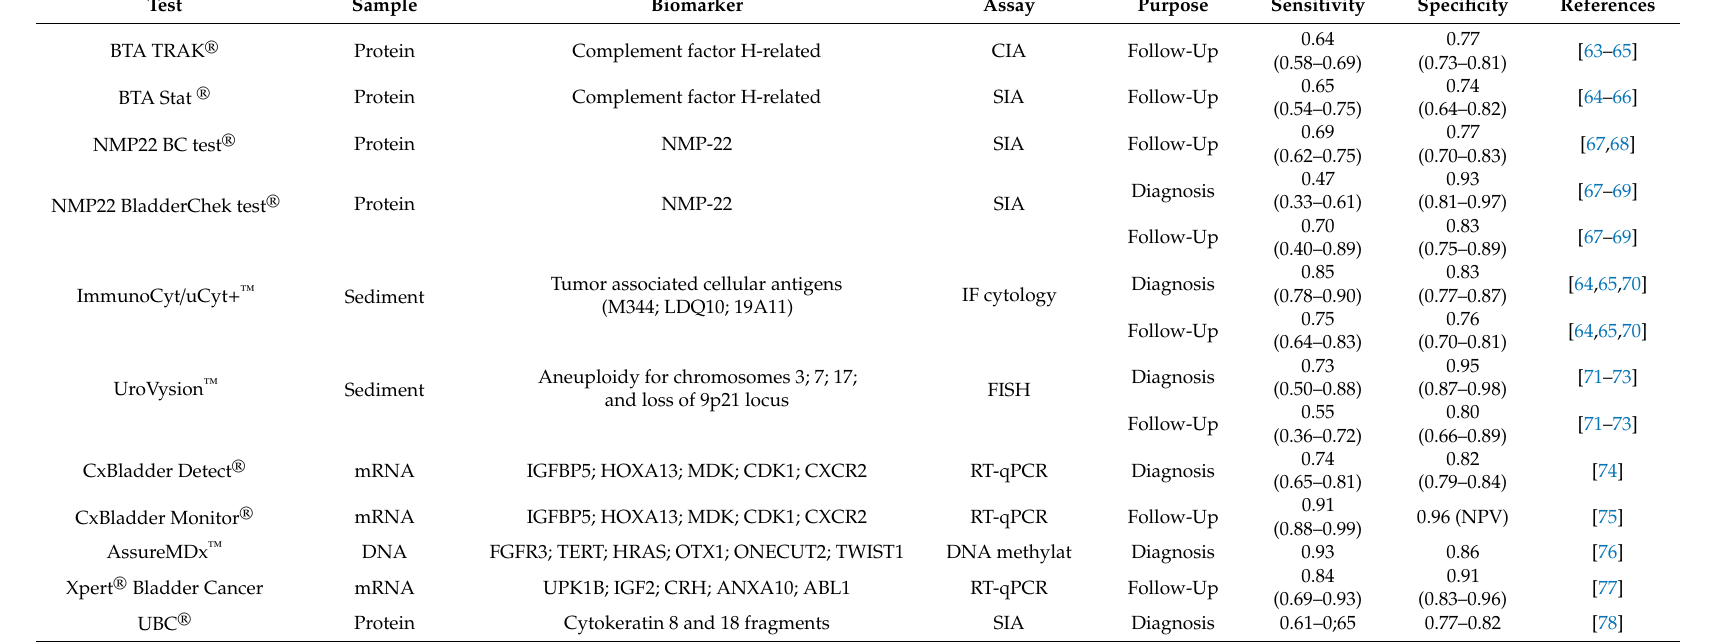
Table 1. Urine-based tests to aid bladder cancer clinical